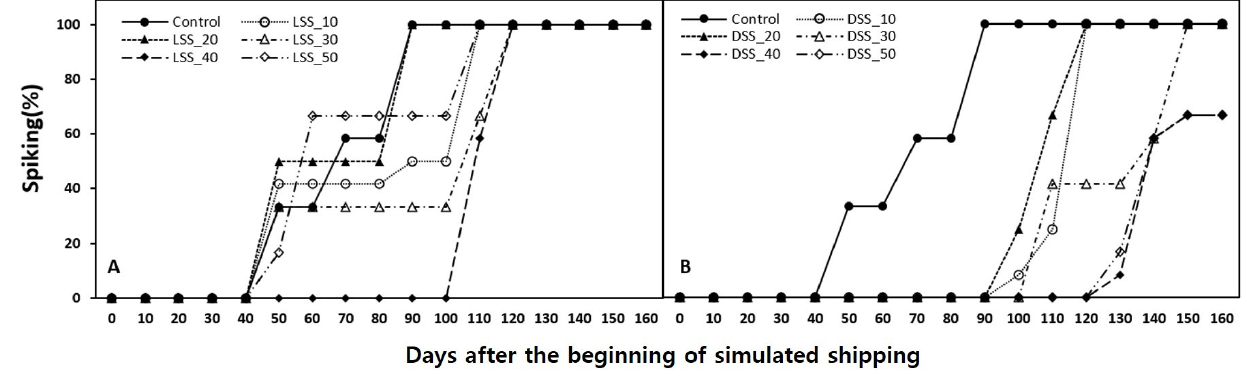
Figure 7. Changes according to time in post-shipping spiking rate as influenced by light ( A ) and dark ( B ) simulated shipping duration in Phalaenopsis Sogo Yukidian ‘V3’.